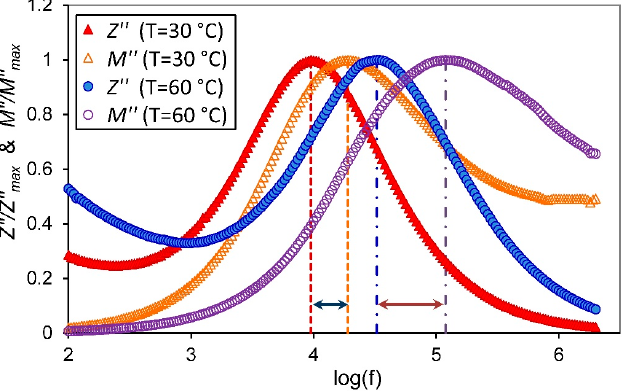
Figure 9. The change of normalized imaginary parts of impedance ( Z (cid:48)(cid:48) / Z (cid:48)(cid:48) max ) and electric modulus ( M (cid:48)(cid:48) / M (cid:48)(cid:48) max ) versus frequency at temperatures of 30 ◦ C and 60 ◦ C for the PVA/NH 4 NO 3 doped 2 wt.% ZnO-NPs.